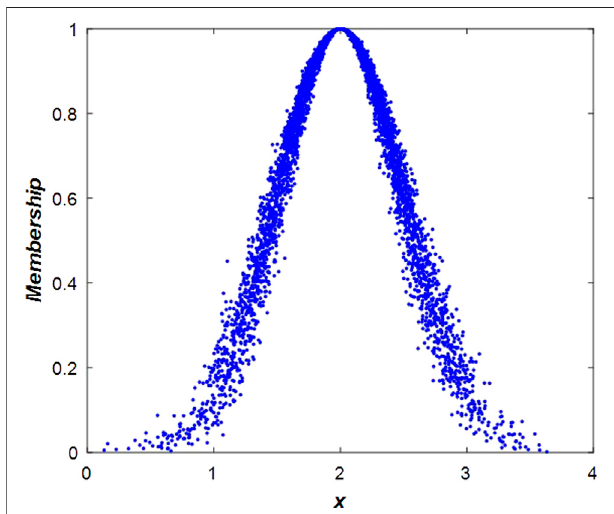
FIGURE 1 | Traditional normal cloud